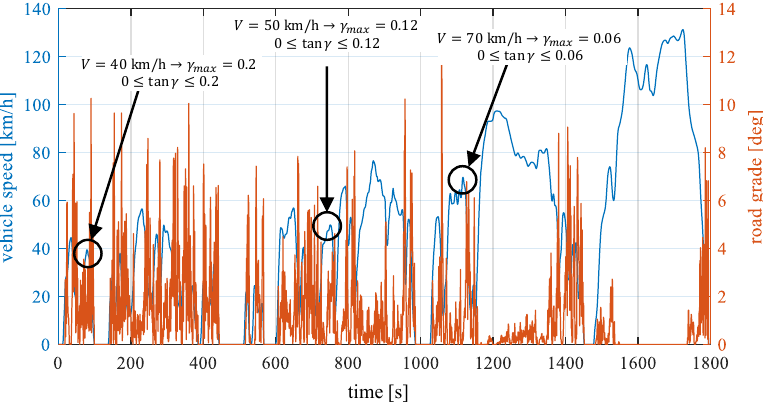
Figure 11. Road grade profile generated during the WLTC-3 cycle.